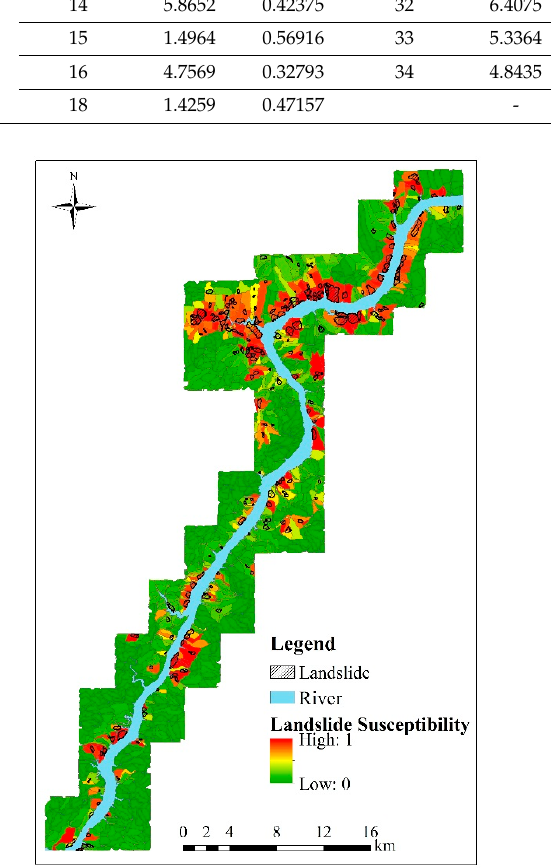
Figure 14. The landslide susceptibility map by the GWR-PSO-SVM model.